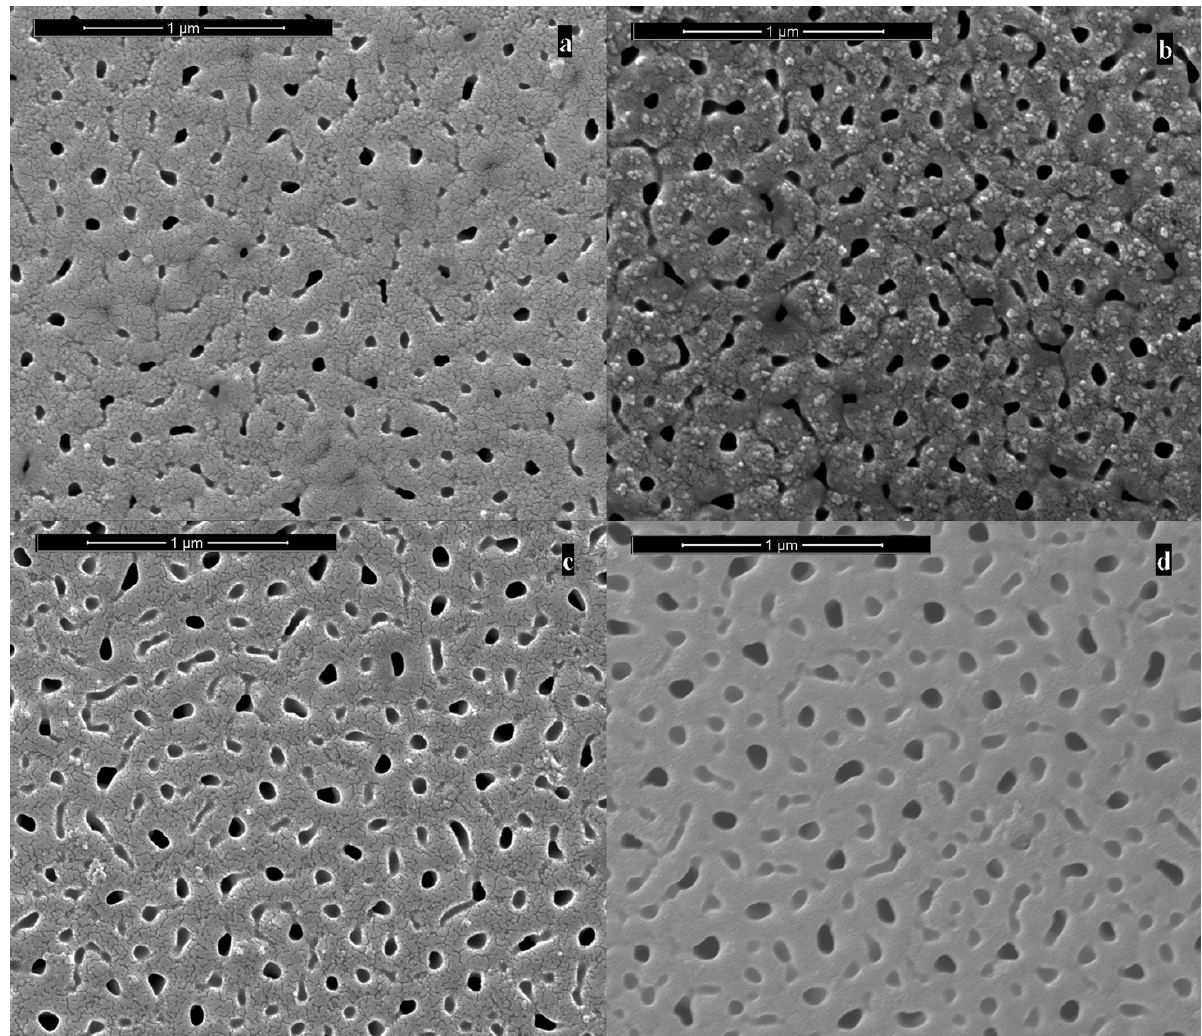
Figure 6. Top-views of PAA layers formed in 0.4 M H 3 PO 4 and 0.13 M Al(OH) 3 at 160 V and 0 °C: ( a ) 20 C cm − 2 ; ( b ) 40 C cm − 2 ; ( c ) 80 C cm − 2 ; ( d ) 160 C cm − 2 .